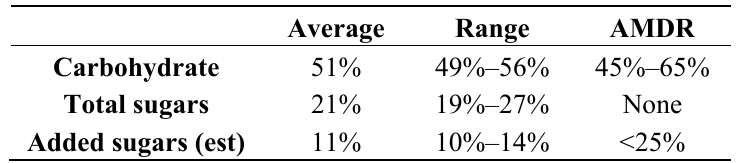
Table 2. The average and range of carbohydrate, sugars, and added sugars intakes among Canadians according to Canadian Community Health Survey (2004) data compared to dietary